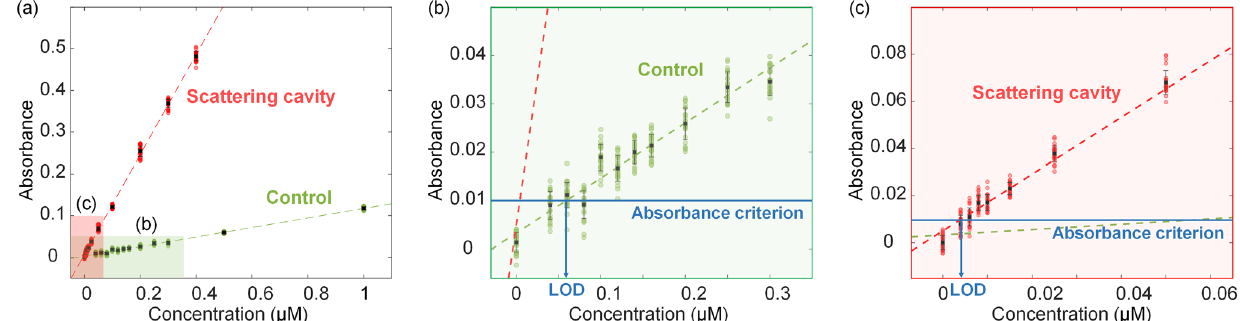
Figure 5. ( a ) Absorbance in malachite green aqueous solutions of low concentrations measured by the conventional method (green) and the scattering cavity (red). ( b , c ) Enlarged shaded areas. The measurements were made 25 times each for all concentrations. Error bars, standard deviations. The absorbance criterion ( μ 0 + 3 σ 0 ) for estimating the concentration corresponding to the LOD is marked with a blue